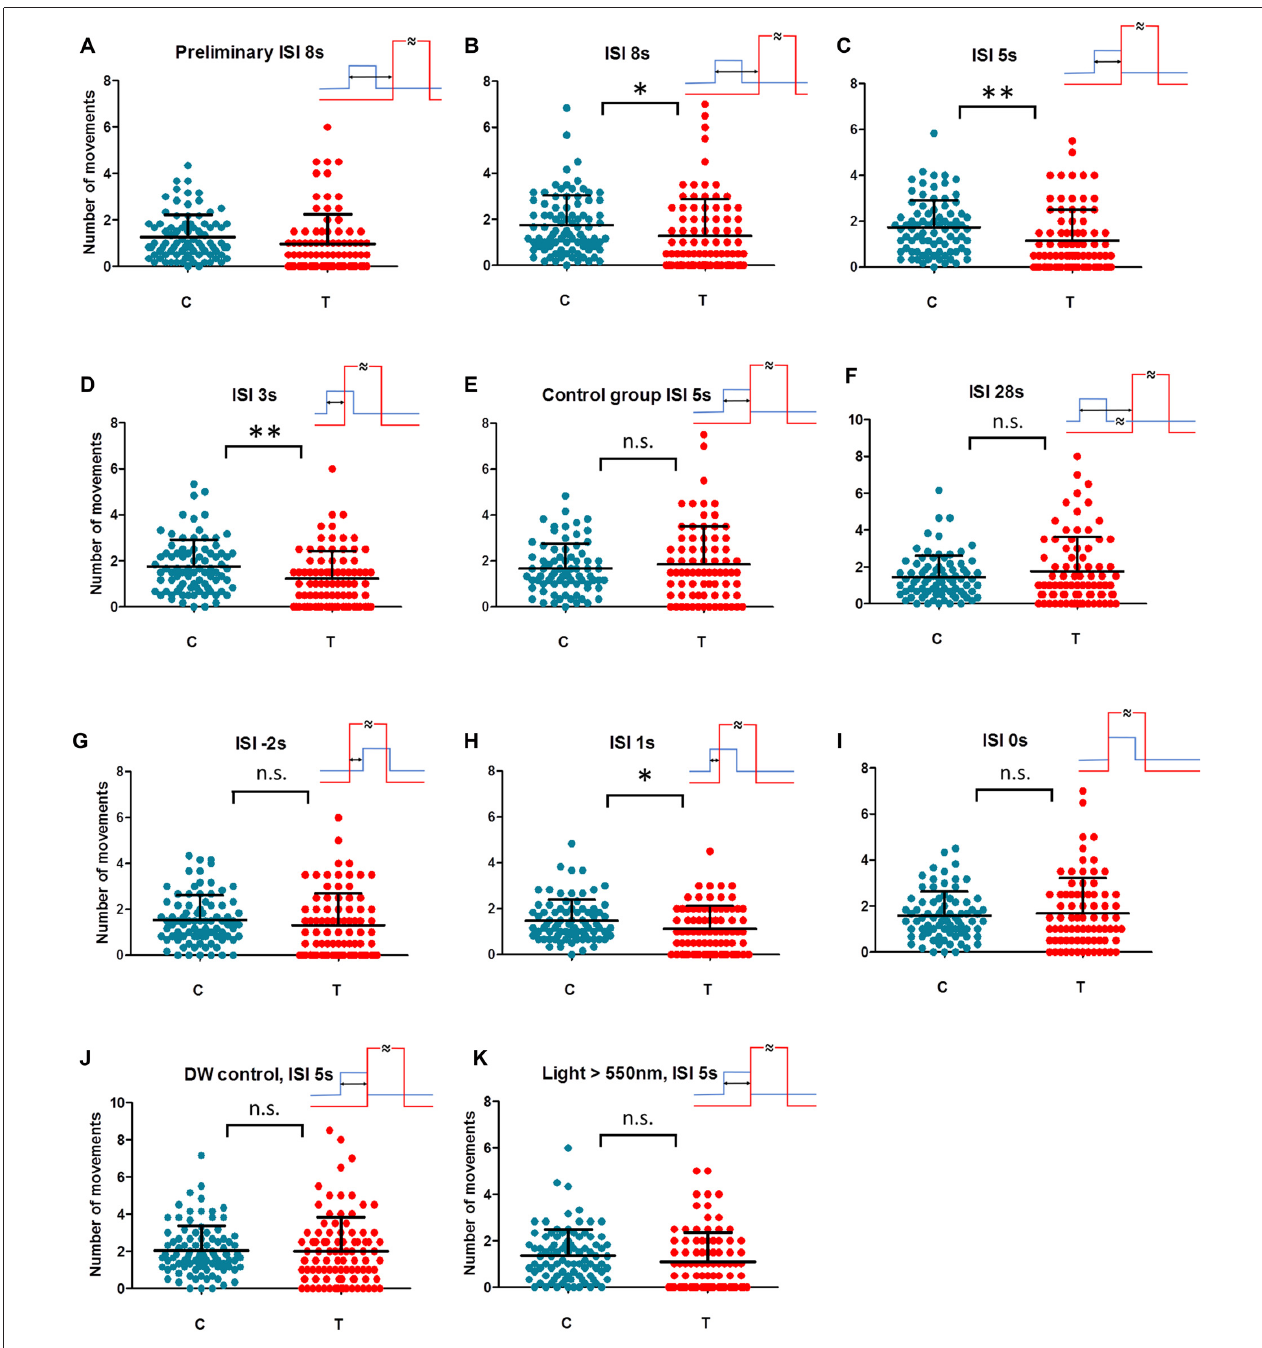
FIGURE 2 | Individual movements under control (C) and magnetically treated (T) conditions in differently trained animals. Animal activity dropped (magnetically induced freezing, MIF) in trained animals with ISI = 8 s in the preliminary test (A) . The hypothesis of MIF was confirmed in the repeated sample (B) . No break between geomagnetic field (GMF) rotation (conditioned stimulus, CS) and hot air (unconditioned stimulus, US) in training (ISI = 5 s) gives the most prominent MIF in the test (C) . When CS and US partially overlap in ISI = 3 s and ISI = 1 s ( D,H respectively) MIF is still significant. MIF disappears in simultaneous ISI = 0 s and also in reversed order training ISI = − 2 s ( I,G respectively). No MIF exists also in the case of too long a break between CS and US in ISI = 28 s (F) . In control samples, animals have been trained in ISI = 5 s but the coil was not fed at all on the next testing day (E) or double wrapped wiring hindered the GMF rotation (J) or short wavelength part of the light spectrum ( < 550 nm) was filtered off (K) . Each dot represents the number of movements of one animal per 30 min. Mean and SD (whiskers) are shown. Training time scheme is given in the upper-right for each condition (rotation of GMF—blue; hot air—red, ISI—two headed arrow). One asterisk: dependent t -test significance between rotating field (RF) and SF P < 0.05, two asterisks: P < 0.01. Detailed courses of each condition are given in complementary Supplementary Figure S4.